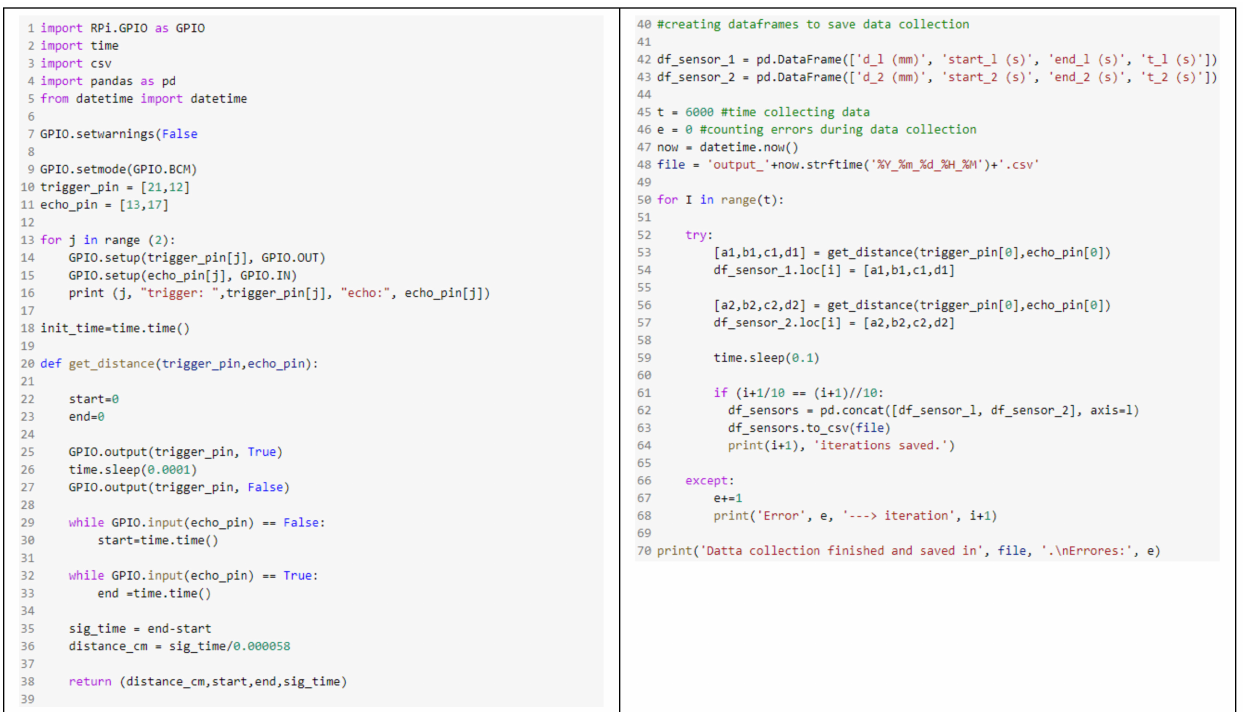
Figure 3. Script programmed in Python for the use of ultrasonic sensor